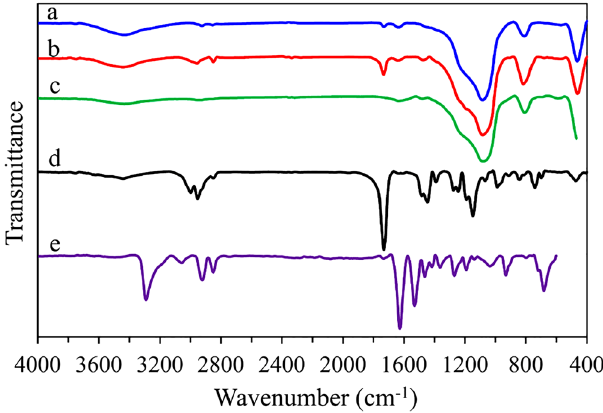
Figure 2. The FT-IR spectra of (a) pristine FDU-12, (b) FDU-12-methacrylate, (c) FDU-12-triamine, (d) FDU- 12-methacrylate/PMMA, and (e) FDU-12-triamine/NY6,6.